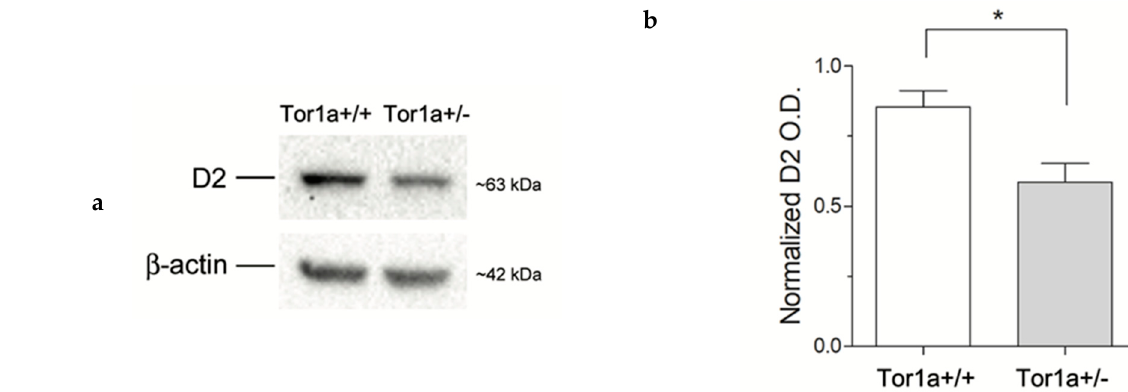
Figure 1. ( a ) Comparative immunoblots of D2 receptors from the striatum of control Tor1a +/+ , and mutant Tor1a +/ − mice. β -actin content was detected as internal reference standard. ( b ) Densitometric analysis of relative optical density (OD) on D2 receptors immune-stained bands. Results were expressed as the mean ± SEM of the values obtained for each separate hemisphere from four mice per group. * p <